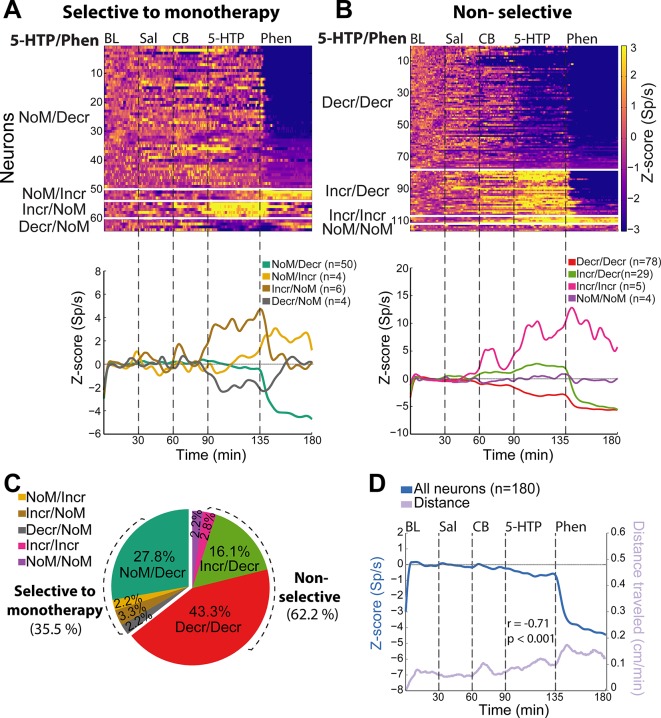
The majority of nucleus accumbens shell (NAcSh) neurons modulated by 5-hydroxytryptophan (5-HTP) are further suppress by phentermine (Phen). (A)
Upper panel: A color-coded peri-stimulus time histogram (PSTH) plotted NAcSh neurons with selective responses to either 5-HTP or Phen. The vertical dotted lines indicated each epoch (baseline, BL; saline, Sal; carbidopa, CB; 5-HTP, and Phen. Lower panel: Population PSTH of all neurons with selective responses to one drug (NoM: Nonmodulated response, Decr: Decrease response, Incr: Increase response). (B) Ensembles of neurons with non-selective responses, same conventions as in panel (A). (C) Percentage of neurons for each modulatory pattern displayed in panels (A and B). (D) Normalized population PSTH of all neurons recorded in NAcSh (blue line; left y-axis) and the total distance traveled across the session (purple line; right y-axis). The Pearson correlation coefficient between locomotion and NAcSh population activity (from 30 to 180 min) is also shown.